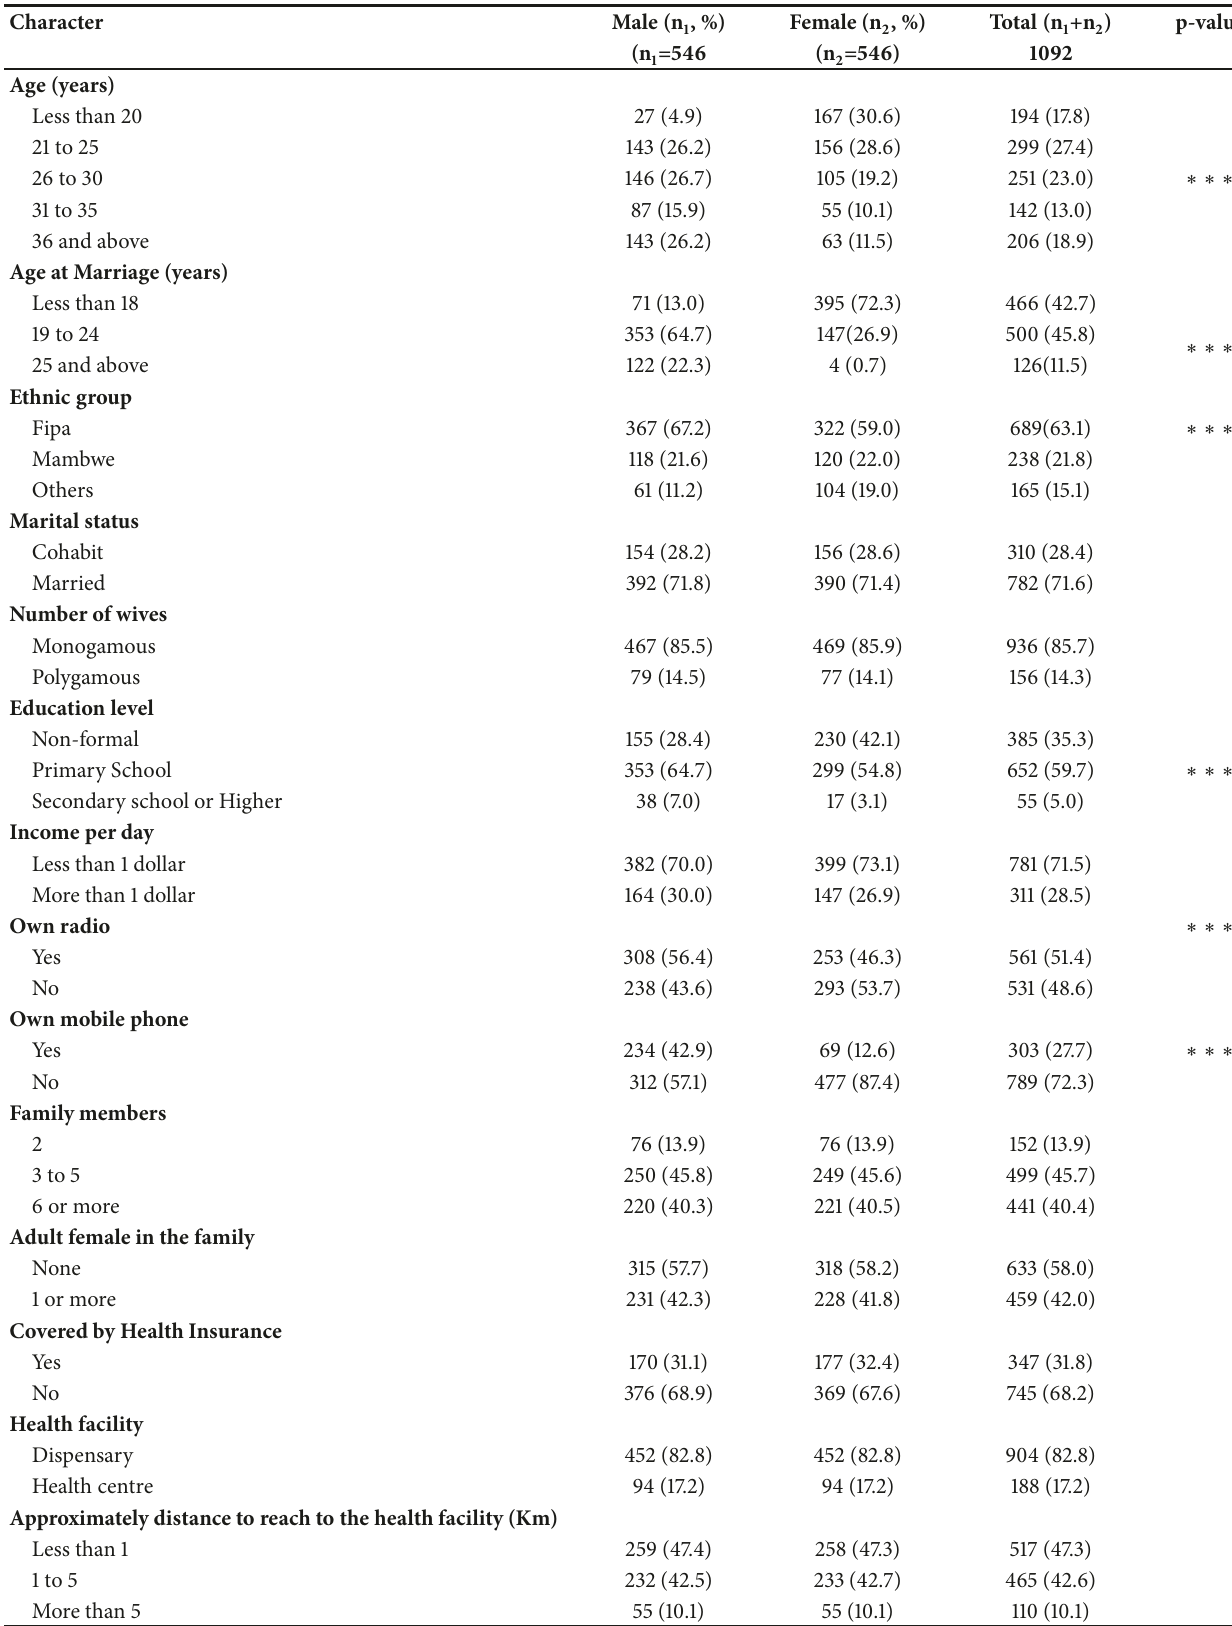
Table 1: Sociodemographic characteristics of